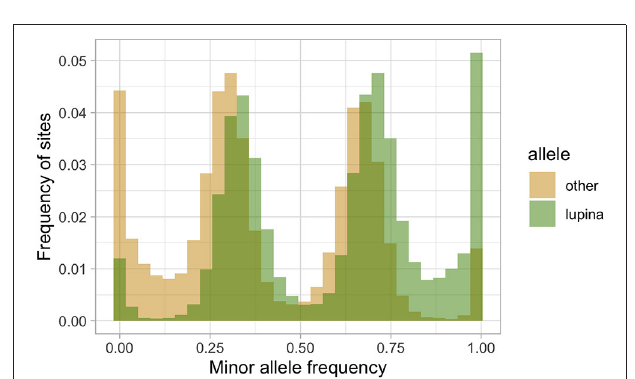
FIGURE 4 | Unfolded allele frequency distribution of the L. lupina metagenome, with alleles classified as either identical to that of the L. lupina pure culture (“lupina”) or an alternative allele